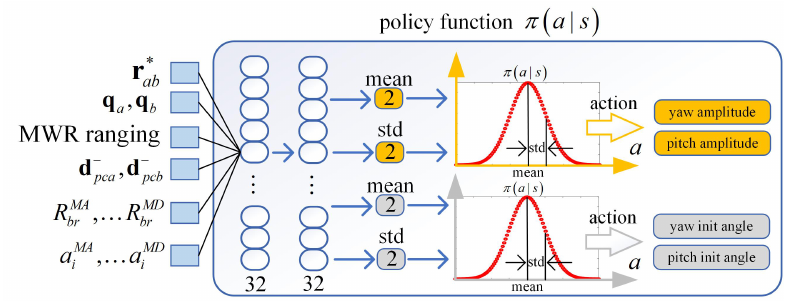
Figure 12. Schematic diagram of extended output policy